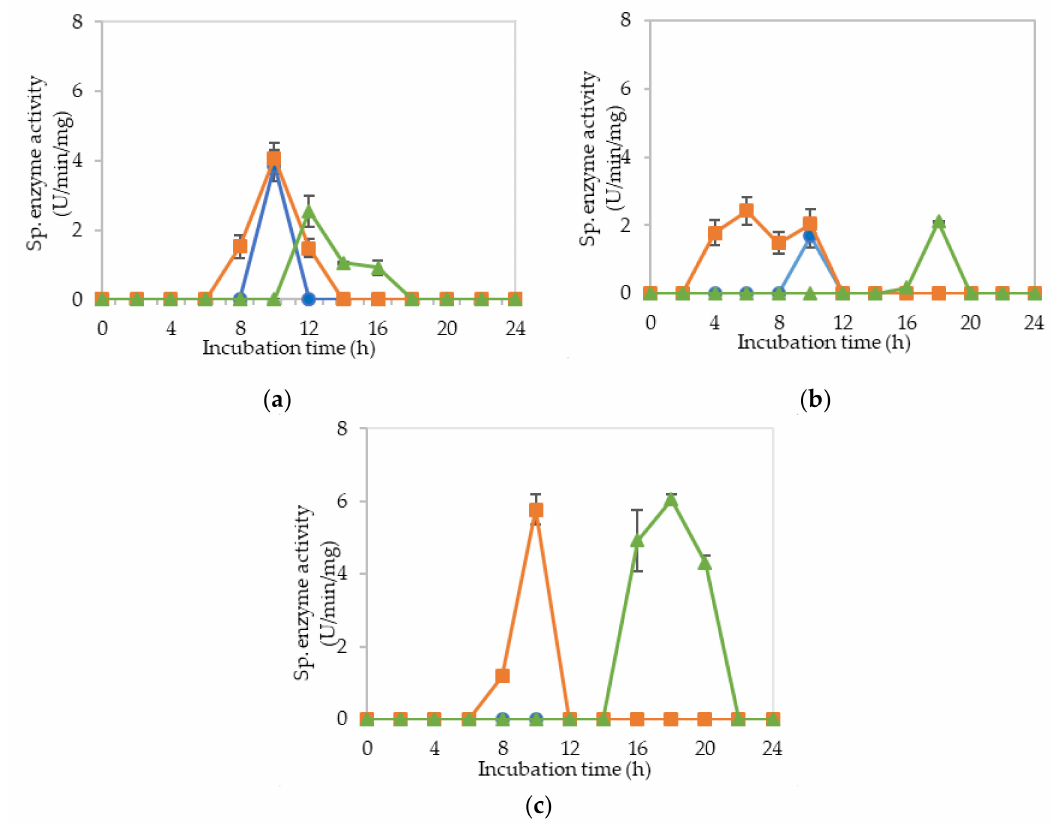
Figure 3. Specific extracellular cellulolytic and hemicellulolytic activities; ( • ) endoglucanase; ( (cid:4) ) exoglucanase; ( (cid:78) ) β -glucosidase and ( (cid:7) ) mannanase of Lactobacillus plantarum RI 11 grown in M1 (rice straw and yeast extract) for 24 h. The enzyme activities were detected at three di ff erent pH levels: ( a ) pH 5; ( b ) pH 6.5; ( c ) pH 8. The error bars represent the standard deviation of specific enzyme activity of triplicate samples ( n =